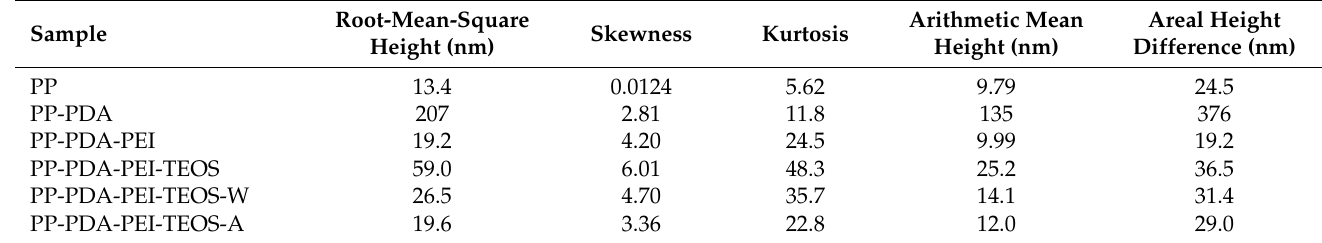
Table 1. AFM-based surface roughness parameters of samples after 7 days of incubation in